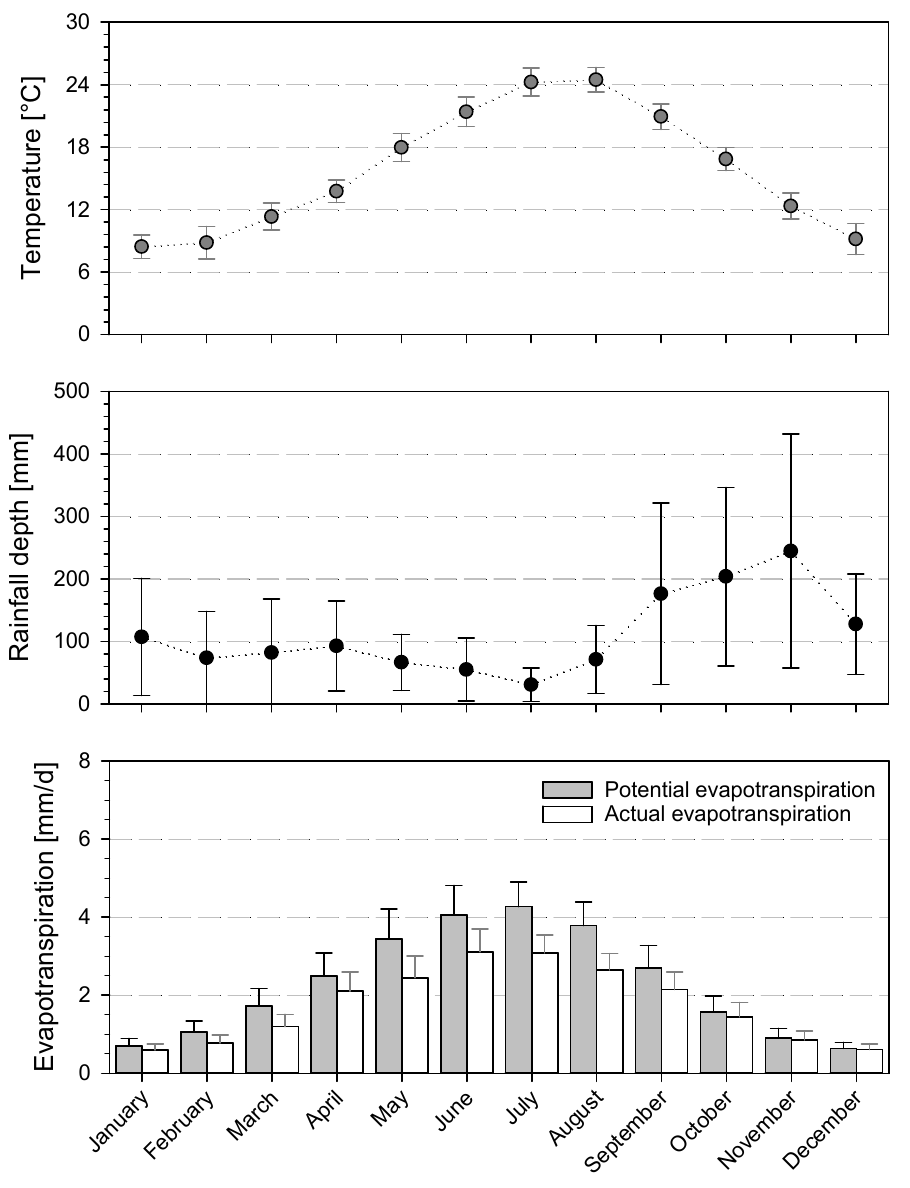
Figure 1. Daily temperature, monthly rainfall depth, potential and actual evapotranspiration for the time series climate records (1990–2015) of Villa Cambiaso (Genoa, Italy). The mean and the corresponding standard deviation values are reported.